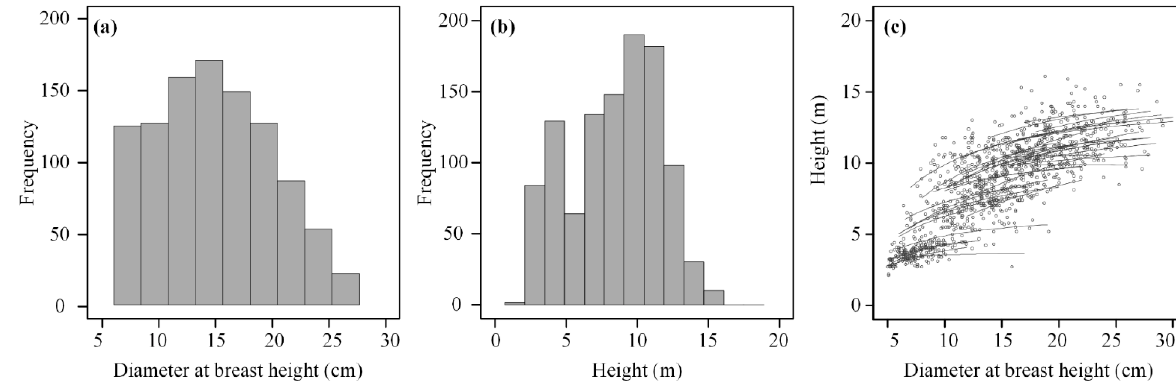
Figure 1. Distributions of the diameter at breast height ( a ) and height ( b ) as well as plot-specific fitted height-diameter lines ( c ). Plot-specific line was obtained by fitting height-diameter (H-D) relationships in each plot using the best basic model determined below.